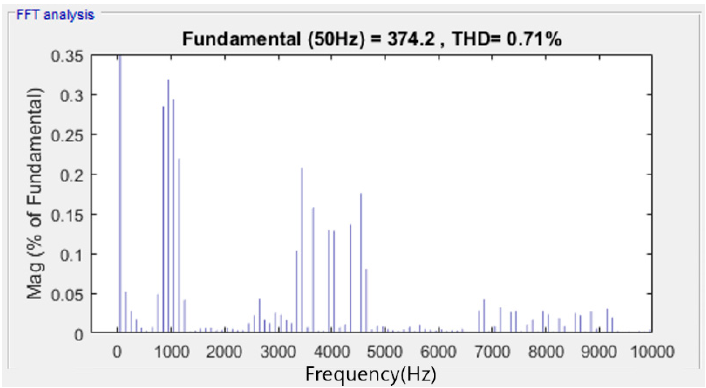
Figure 22. Three-phase four H-bridge CHB current THD for PS PWM and worst switching of non-equal sources.